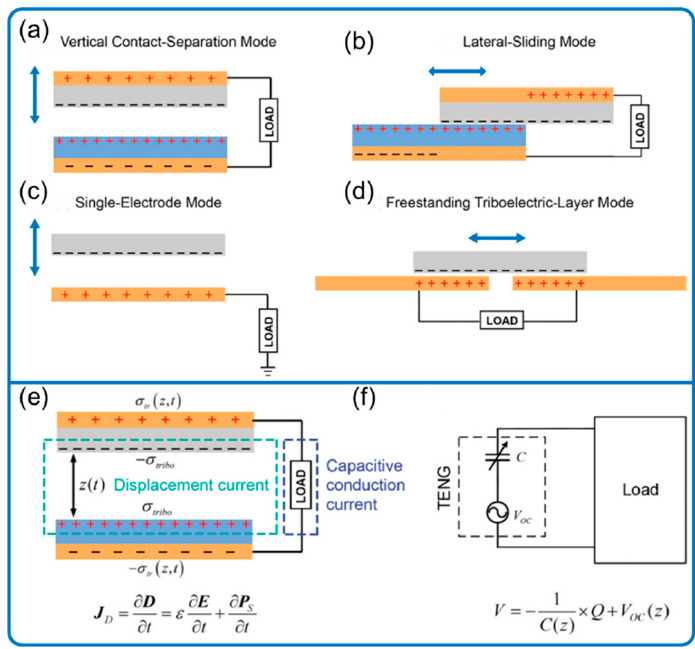
Figure 2. The four basic modes of TENG and its equivalent model. ( a ) Vertical contact separation mode, ( b ) lateral sliding mode, ( c ) single-electrode mode, and ( d ) freestanding triboelectric-layer mode. ( e ) The displacement current model of a contact-separation mode. ( f ) TENG’s equivalent electrical circuit model. Reproduced with permission. Copyright 2018, Wiley Online Library [1].